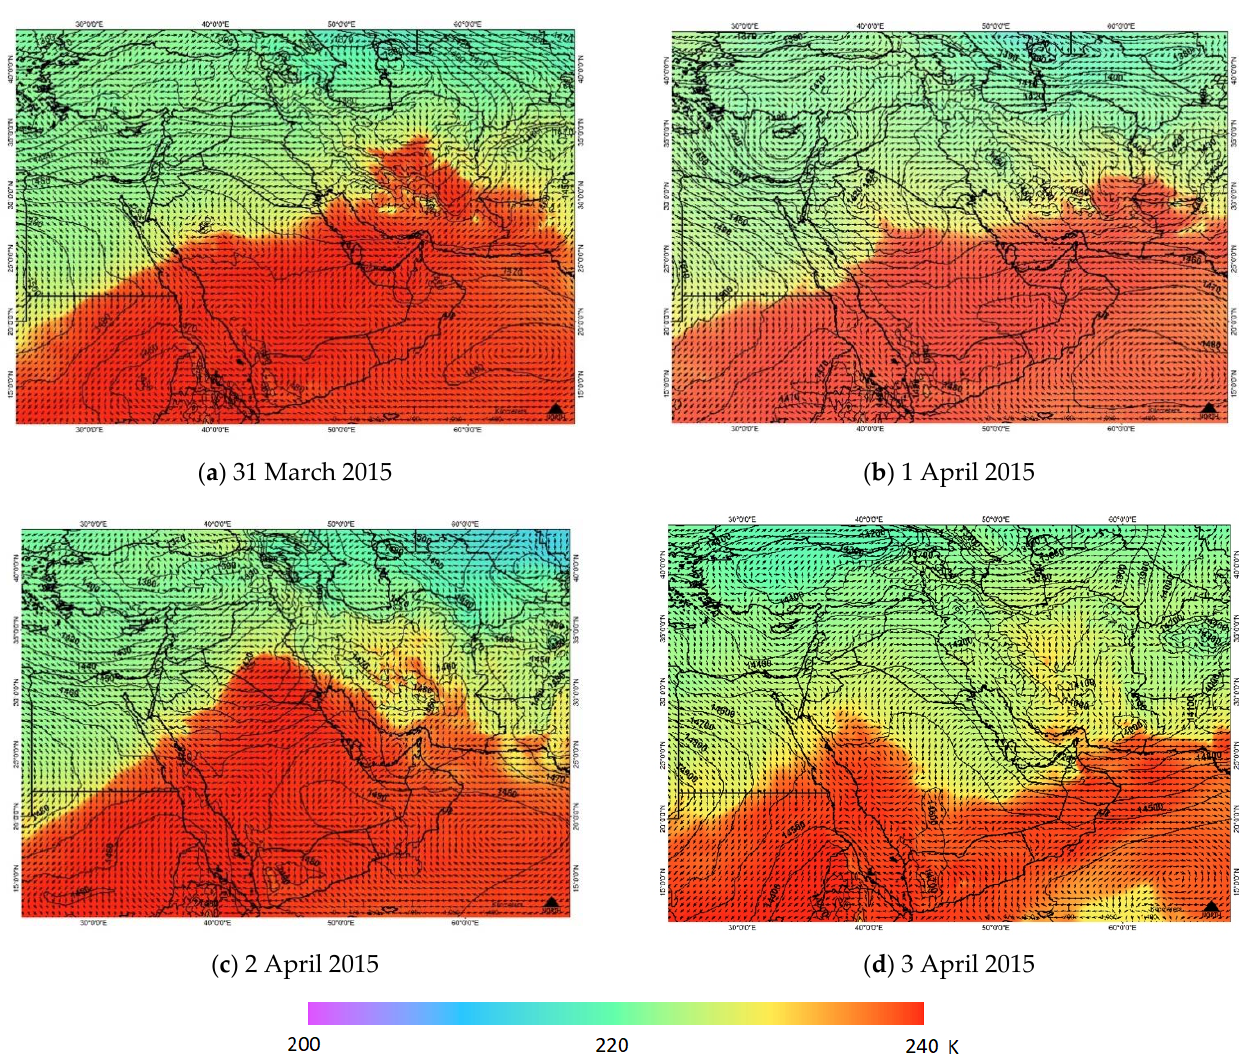
Figure 2. Contours indicate the daily 850 hPa geopotential heights (m) overlaid with 850 hPa wind vectors (m/s) and temperature (K) derived from ERA5 data from 31 March to 3 April 2015 (12:00 UTC) ( a – d ).